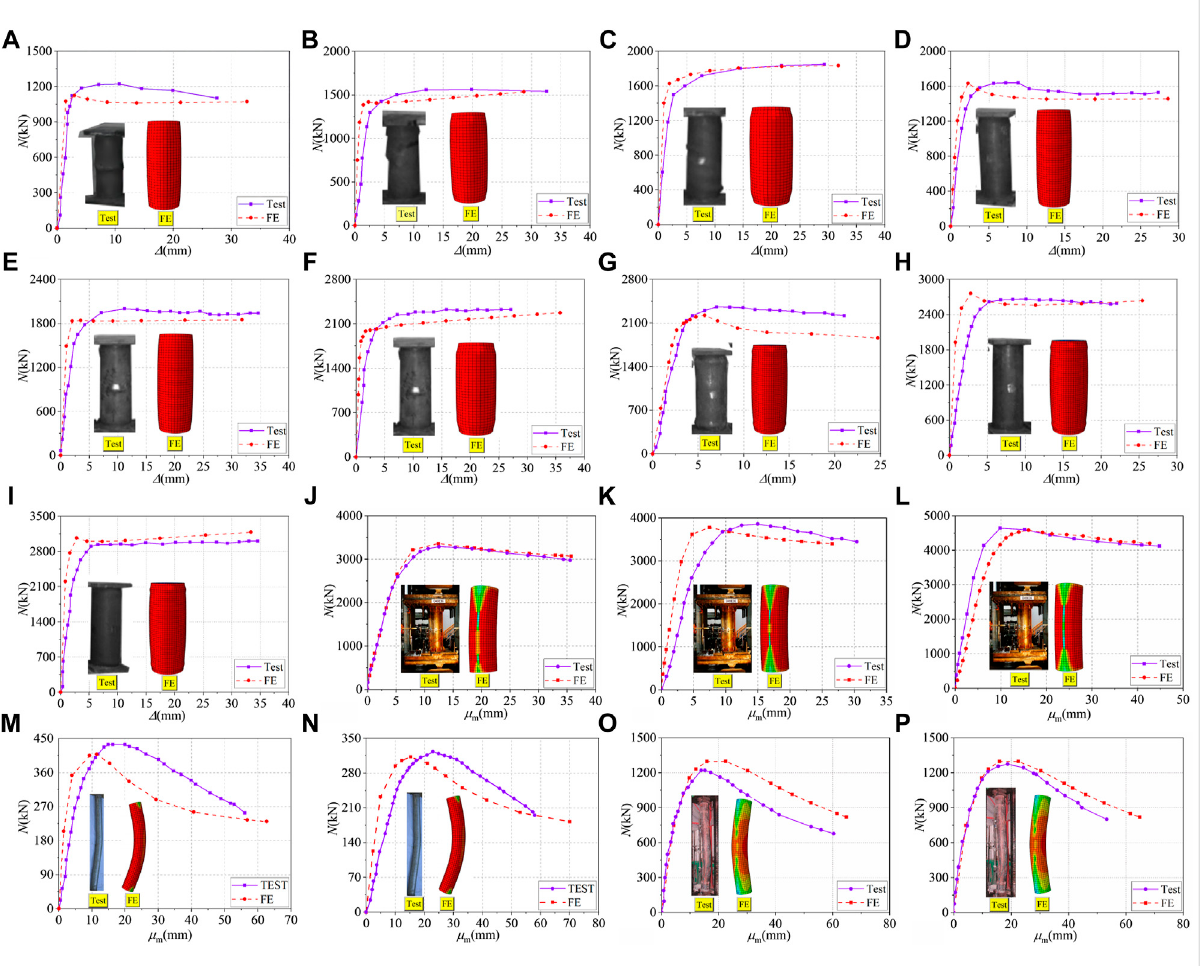
FIGURE 4 Compression for N - Δ and N - µ m curves between simulation and test results: (A) CSCA-1; (B) CSCA-2; (C) CSCA-3; (D) CSCB-1; (E) CSCB-2; (F) CSCB-3; (G) CSCC-1; (H) CSCC-2; (I) CSCC-3; (J) E40-30; (K) E40-60; (L) E60-30; (M) C150-4; (N) C150-6; (O) LCSC2-1; (P) LCH2-1.